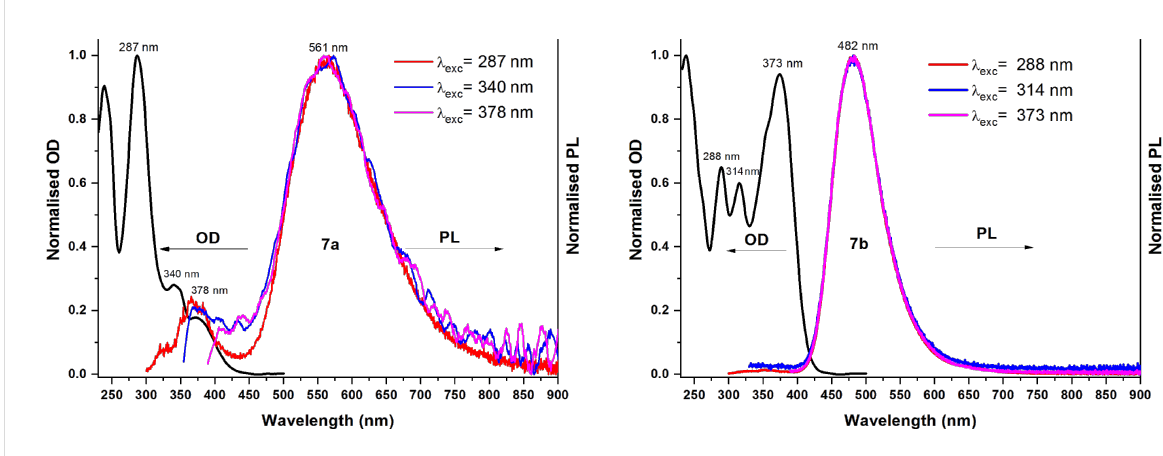
Figure 4: Normalised UV–vis and PL spectra of compounds 7a and 7b in dichloromethane.